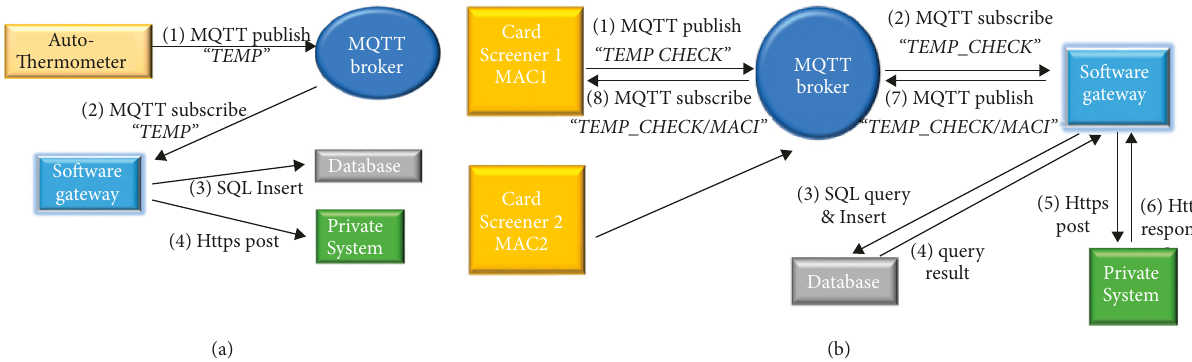
Figure 9: Data flow of the autothermometer (a) and card screener